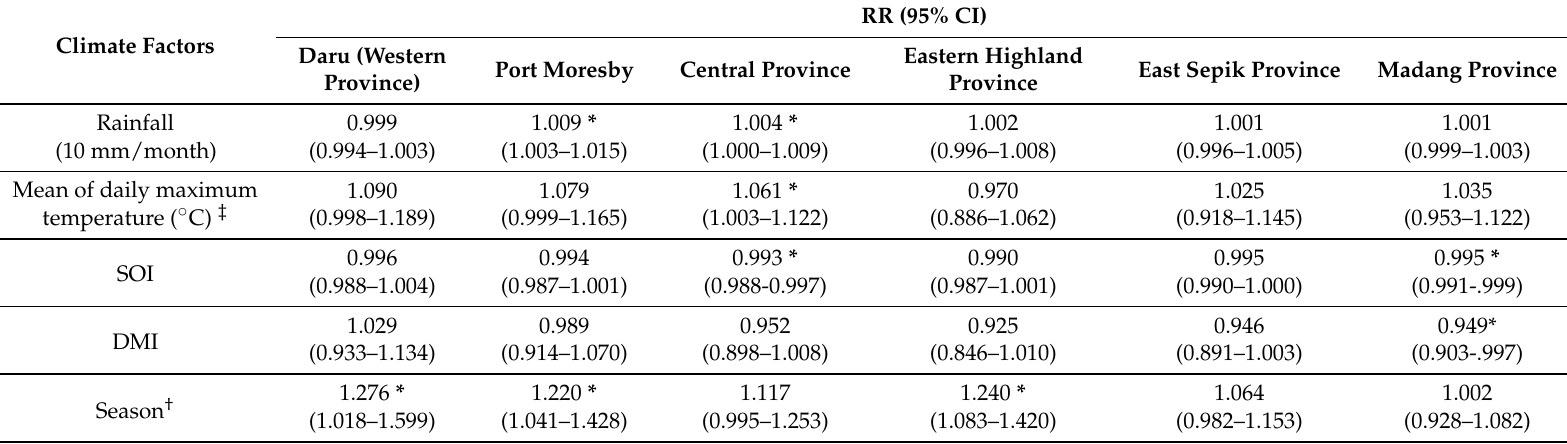
Table 3. Relative risk for independent variables of climate for childhood pneumonia using generalized linear model in six areas in Papua New Guinea between 1997 and